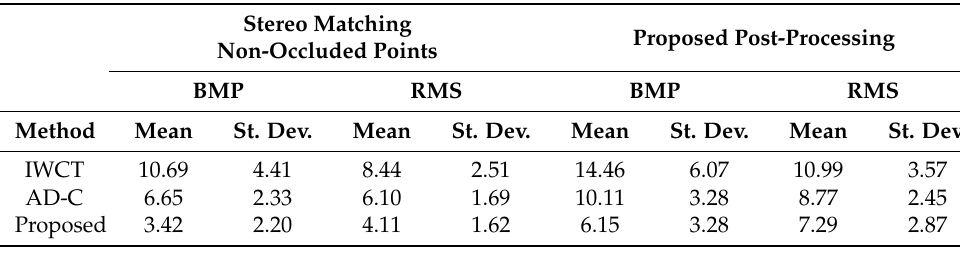
Table 1. Statistical results in terms of BMP and RMS for stereo matching of non-occluded points and evaluation of the proposed post-processing